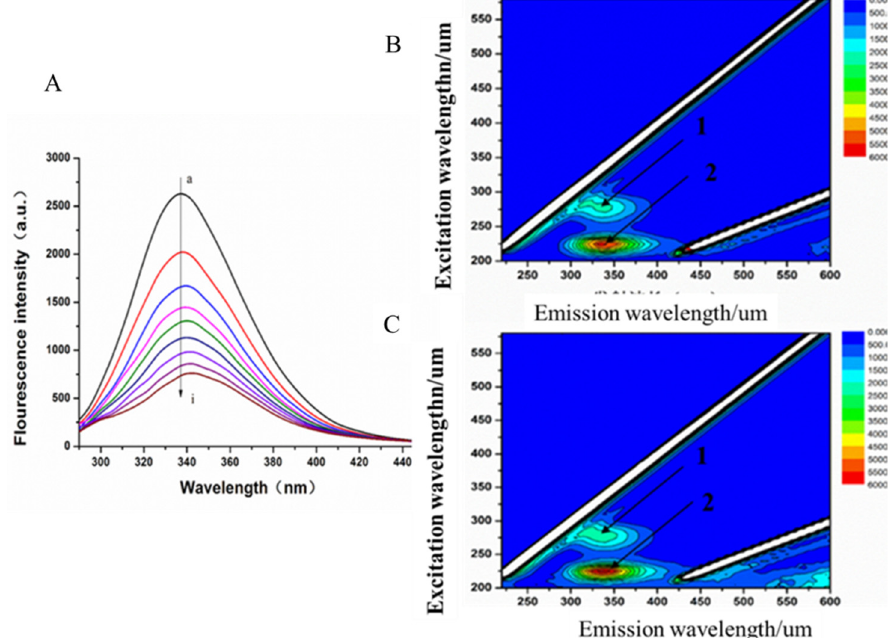
12 of 19 According to the fluorescence spectra obtained after adding different concentrations of LB at different temperatures (305 K, 310 K and 315 K), the fluorescence intensity of